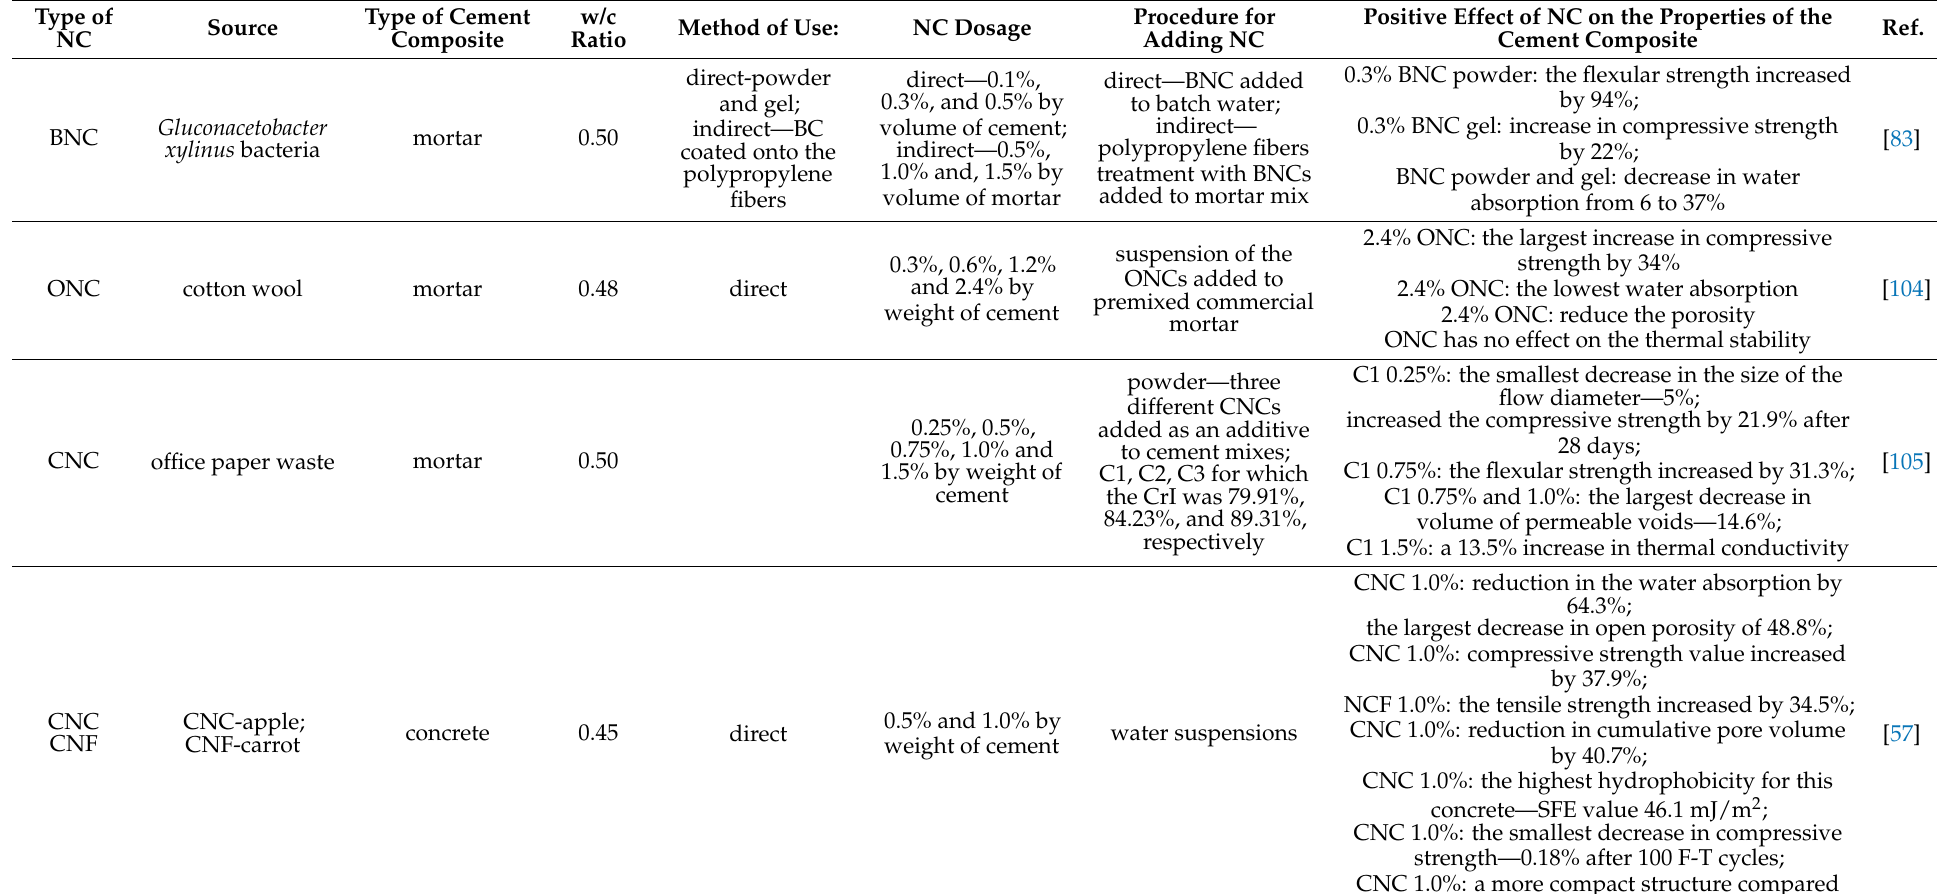
Table 4. Summary of information contained in Section